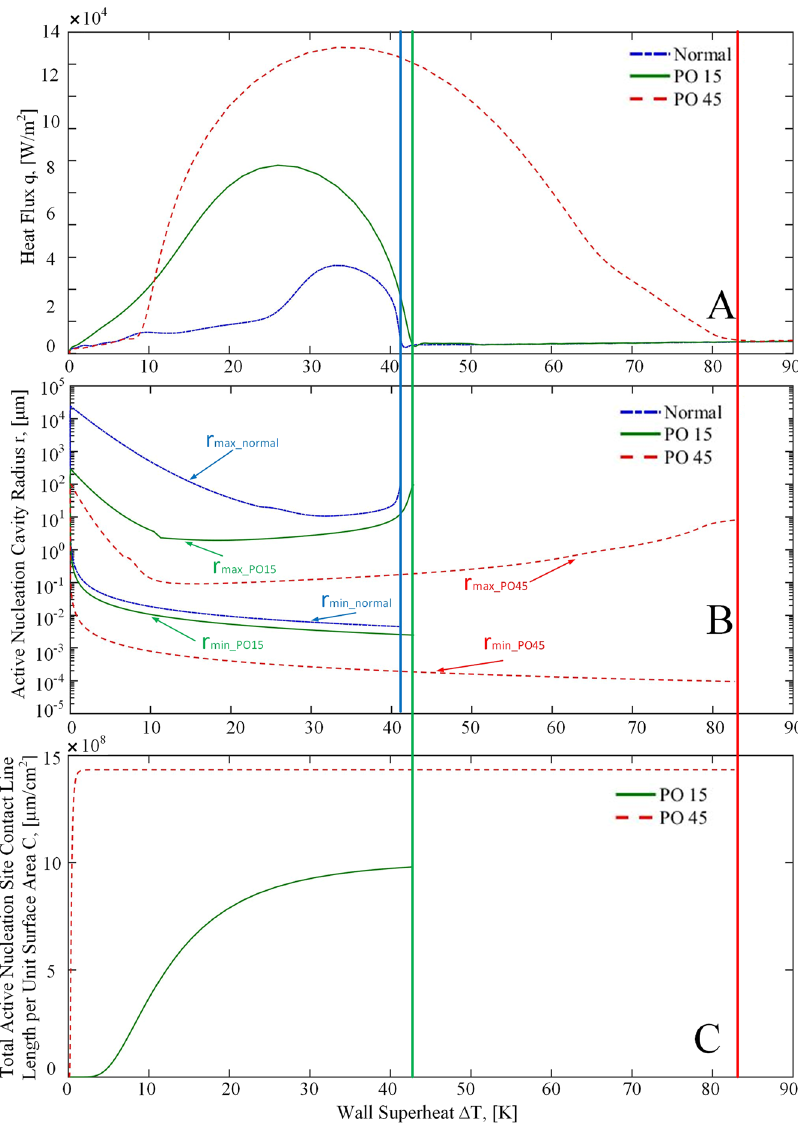
Figure 8. Active Nucleation cavity radii and total active nucleation site contact line lengths based on quenching boiling curve. ( A ) Boiling curve in transition and nucleate boiling regime. ( B ) Active nucleation site radius range ( C ) total circumference length of active nucleation sites per unit surface